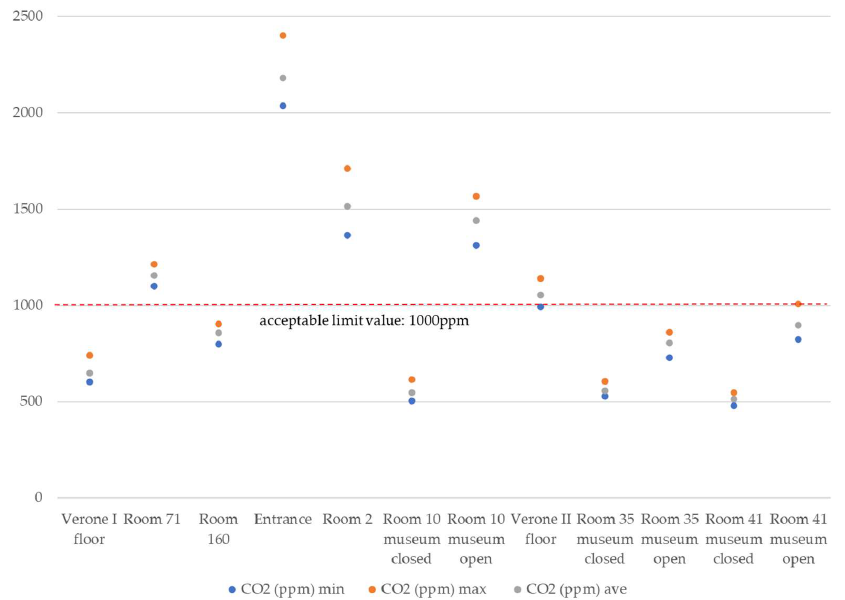
Figure 7. Minimum, average and maximum measured values for carbon dioxide concentration (CO 2 [ppm]) compared together with value ranges considered acceptable for people.